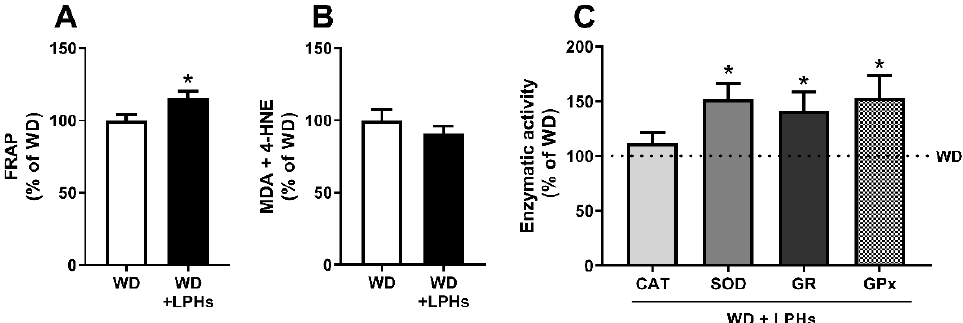
Figure 5. Hepatic antioxidant status. FRAP ( A ), MDA and 4-HNE levels ( B ) and CAT, SOD, GR, and GPx antioxidant activities ( C ) in the liver of ApoE − / − mice after 12 weeks of treatment with LPHs. After referring the data to mg of protein, results are expressed as a percentage of the WD group. Data represent the mean and standard error of the mean of each group ( n = 15). The pointed line represents WD group, while the bars represent the LPHs effects with respect to WD group ( C ). * p ≤ 0.05 with respect to the WD group. 4-HNE, 4-hydroxy-2-nonenal; CAT, catalase; FRAP, ferric reducing antioxidant power; GPx, glutathione peroxidase; GR, glutathione reductase; GSH, glutathione; MDA, malondialdehyde; SOD, superoxide dismutase; WD, western diet group; WD+LPHs, western diet + lupin protein hydrolysates group.